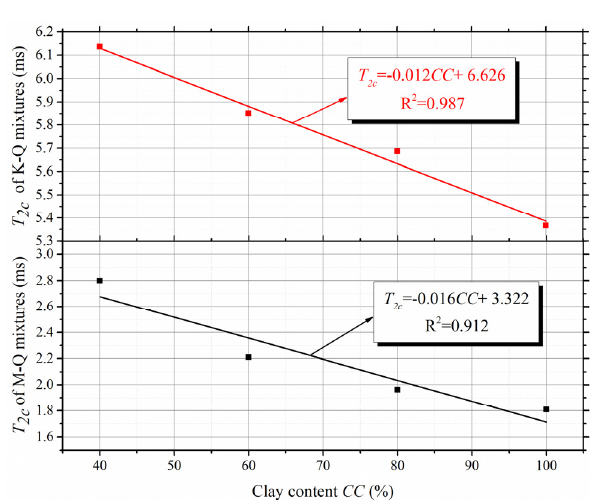
Figure 11. The relationships between T 2 c and the clay content (CC). The lines at the top and bottom indicate the relationships between the T 2 c and CC of kaolinite-quartz (K-Q) and montmorillonite-quartz (M-Q) mixtures, respectively. The Equations in the two boxes are the Equations of the two lines. R 2 indicates the correlation coefficient of the Equation.